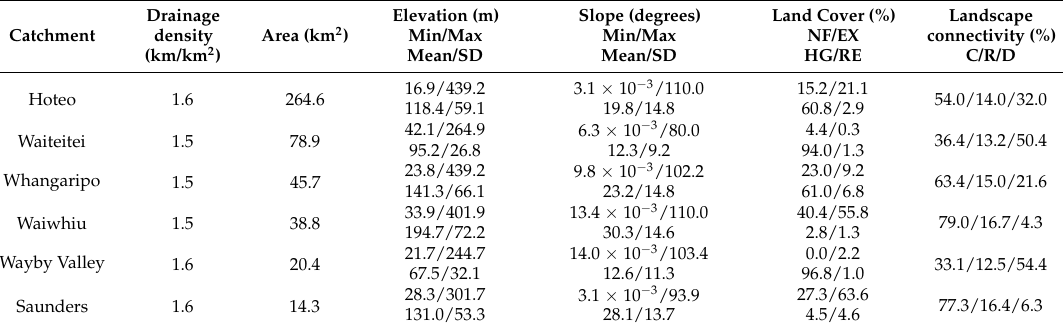
Table 2. Physiographic characteristics of the study area (Hoteo) and its sub-catchments. Land covers are native forest (NF), exotic forest (EX), high-producing grasslands (HG), and Rest (RE). Landscape connectivity refers to Connected (C), River and floodplain buffer (R), and Disconnected (D).